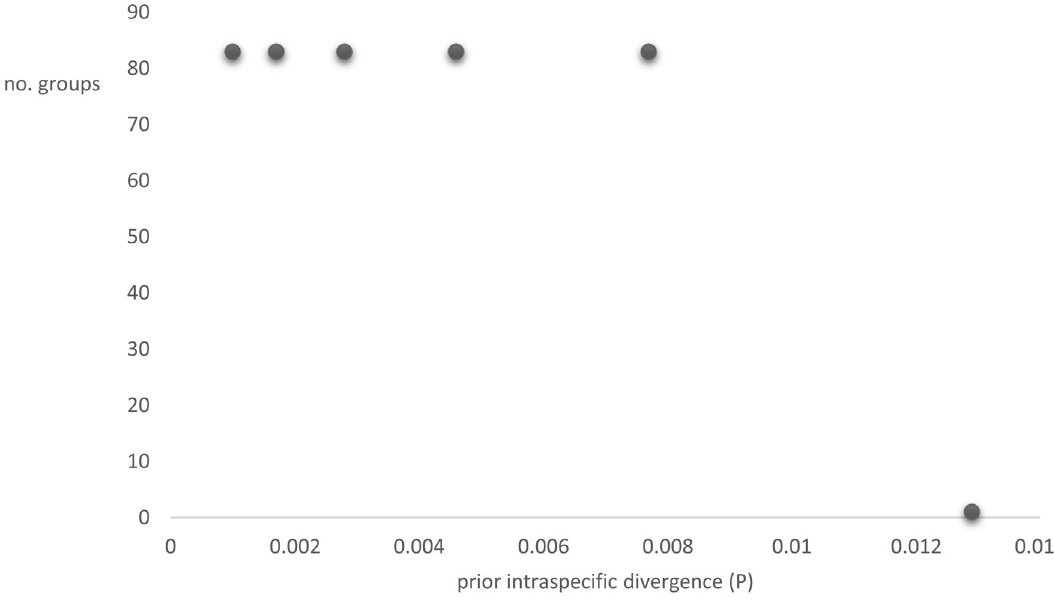
Figure 1. LSU data partition from Automatic Barcode Gap Detection